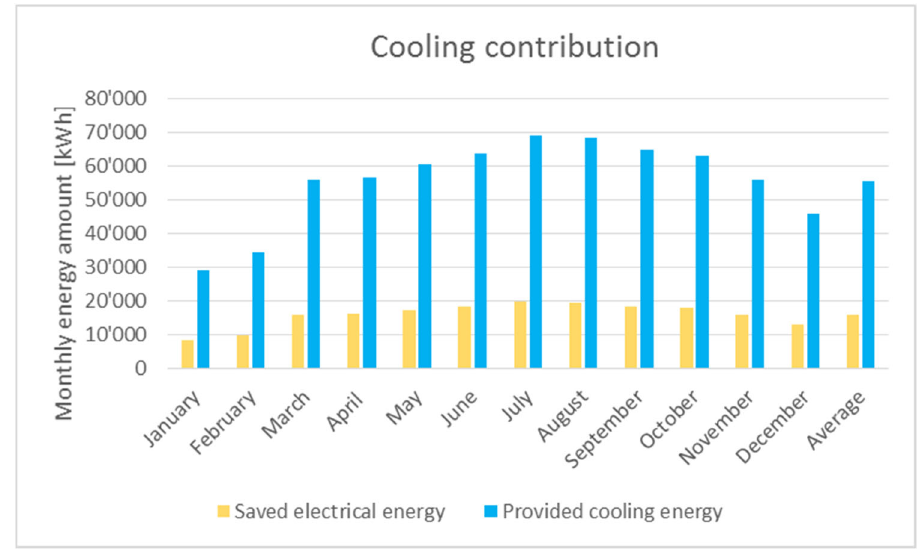
Figure 15. Energy saving due to the employment of the integrated machine as a support for the existing air conditioning system.